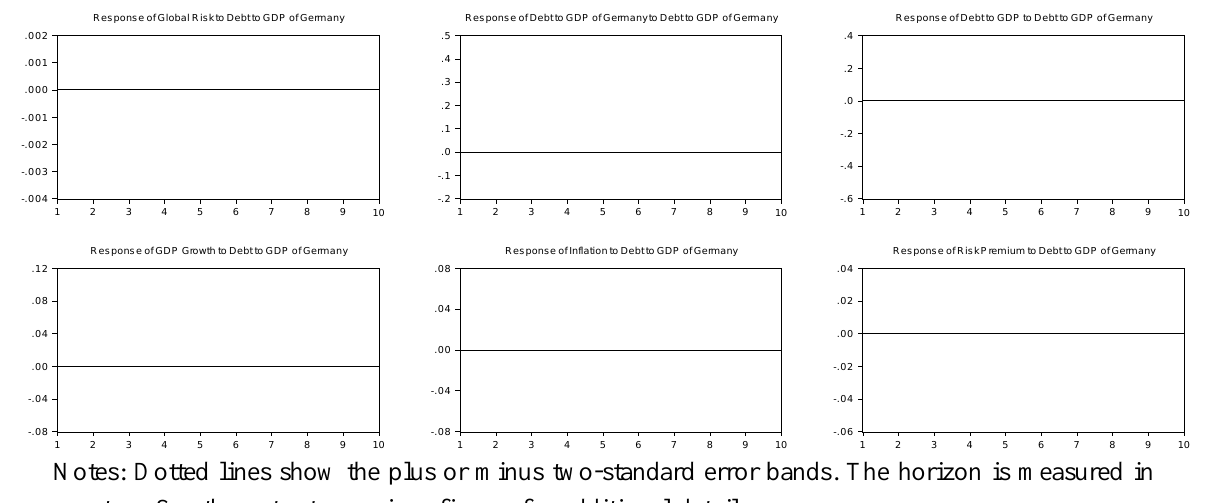
Figure 15. Pre-crisis response of EMU countries to a shock to the German debt-to-GDP ratio: